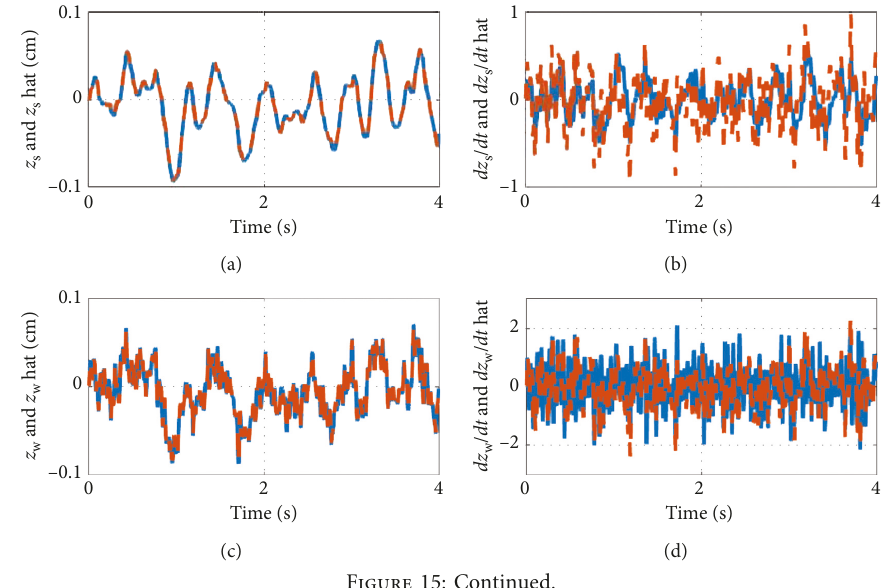
s and z s hat. (b) dz s / dt and dz s / zr